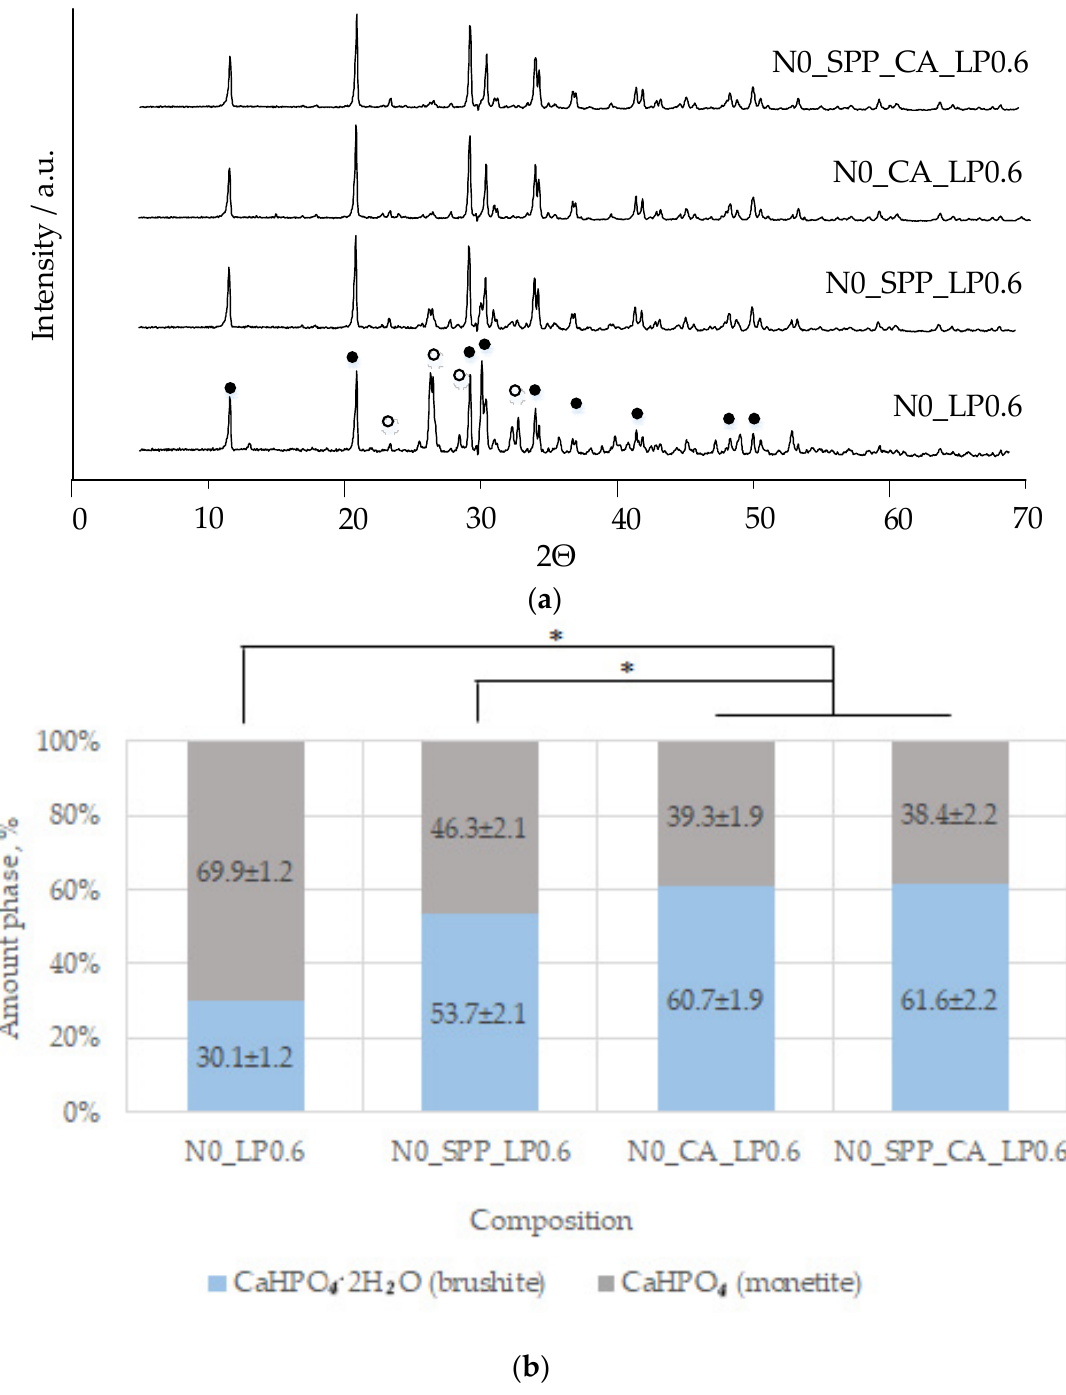
( b ) Figure 3. Diffractograms ( а ) and quantitative phase composition ( b ) of ceramics: CaHPO 4 ·2H 2 O Figure 3. Diffractograms ( a ) and quantitative phase composition ( b ) of ceramics: CaHPO 4 · 2H 2 O Figure 3. Diffractograms ( а ) and quantitative phase composition ( b ) of ceramics: CaHPO 4 ·2H 2 O Figure 1. X-ray diffraction pattern of Mg x Ca 3 − x (PO 4 ) 2 powders for Mg0, Mg0.75, Mg1.5, Mg2.25, (brushite); CaHPO 4 (monetite). Significant differences are labeled with * ( p < 0.05). (brushite); CaHPO 4 (monetite). Significant differences are labeled with * ( p < 0.05). where is tricalcium phosphate Ca 3 (PO 4 ) 2 (TCP); is magnesium calcium phosphate is trimagnesium phosphate Mg 3 (PO 4 ) 2 . The possibility of separate and joint use of the additive inhibitors SPP and CA on the properties of ceramics in experiments in vitro and in vivo with the example of ceramics The particles of all compositions had an irregular shape. The particle size did not N0 were investigated in this work. The study of the effect of the concentration of differ for all compositions (Figure 2). The results of energy dispersion analysis confirm the magnesium ions in magnesium-calcium phosphate ceramics was carried out for variable composition of the solid-phase synthesis product (Table 3). Mg/Ca ratios compositions N0, N20, N40, and N60 at optimal concentrations of a mixture of additives determined by EDS resulted in Mg0.75, Mg1.5, and Mg2.25 composition of 0.74/2.26, for each composition in accordance with Table 4. 1.51/1.49, and 2.17/0.83, respectively. This is slightly different from the target values. The introduction of retarding additives significantly affects the composition, Table 2. Surface area and average particle size of Mg x Ca 3 − x (PO 4 ) 2 powders for Mg0, Mg0.75, Mg1.5, increasing the amount of brushite in the composition of ceramics. In compositions with and Mg2.25. 0.3 M CA and 0.1 M CA + 0.033 M SPP, the amount of the CaHPO 4 ·2H 2 O phase is higher than when using 0.066 M SPP solution. A combination of retarding additives and an Parameter Mg0 Mg0.75 Mg1.5 Mg2.25 increase in the L/P ratio to 0.7 is necessary to obtain a single-phase brushite product. 3.2795 ± 3.6986 ± When using Mg x Ca 3 − x (PO 4 ) 2 at Mg0.75, Mg1.5, and Mg2.25, newberyite Surface area, m 2 /g 3.4399 ± 0.0741 3.4947 ± 0.1083 0.1916 MgHPO 4 ·3H 2 O (72-23 PDF-2) is present in the composition of ceramics N20, N40, and N60 in addition to the phases СаНРО 4 ∙2Н 2 О and СаНРО 4 (Figure 4). An increase in the L/P ratio from 0.6 to 0.7 slightly reduces the amount of monetite and does not allow it to be completely excluded. The amount of newberyite, according to the calculation of corundum numbers, has slightly lower values than predicted. The difference increases from N20 to N60. The microstructure of ceramics is mainly represented by sharp-angled lamellar and prismatic (in the form of parallelepipeds) crystals of brushite and monetite with a length of mainly less than 10 microns (Figure 5). Crystals of up to 20 – 30 microns in length are observed at the boundary of the pore space, where there are no obstacles to growth. Retarder additives reduce the size of crystals located at the boundaries of pores. When magnesium is introduced into ceramics, prismatic crystals are observed (shown by arrows), similar to newberyite crystals, according to the literature data [32,39,40].